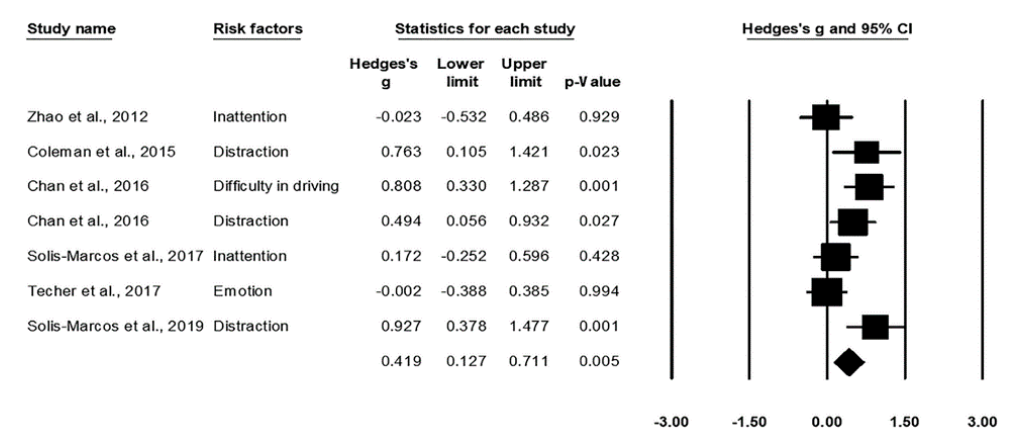
Figure 4. Forest plot for P300 latency in relation to the risk factors.